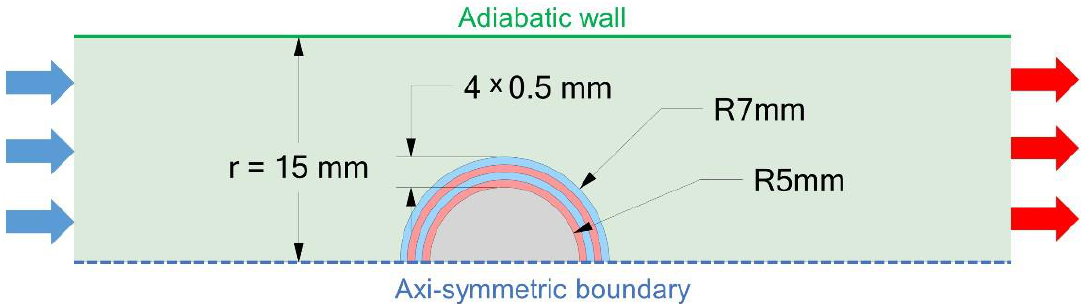
Figure 1. Simulation domain with the ammonia fluid (green cylinder) surrounding the core n-eicosane (grey sphere) and the PVDF shells (red and blue shells).